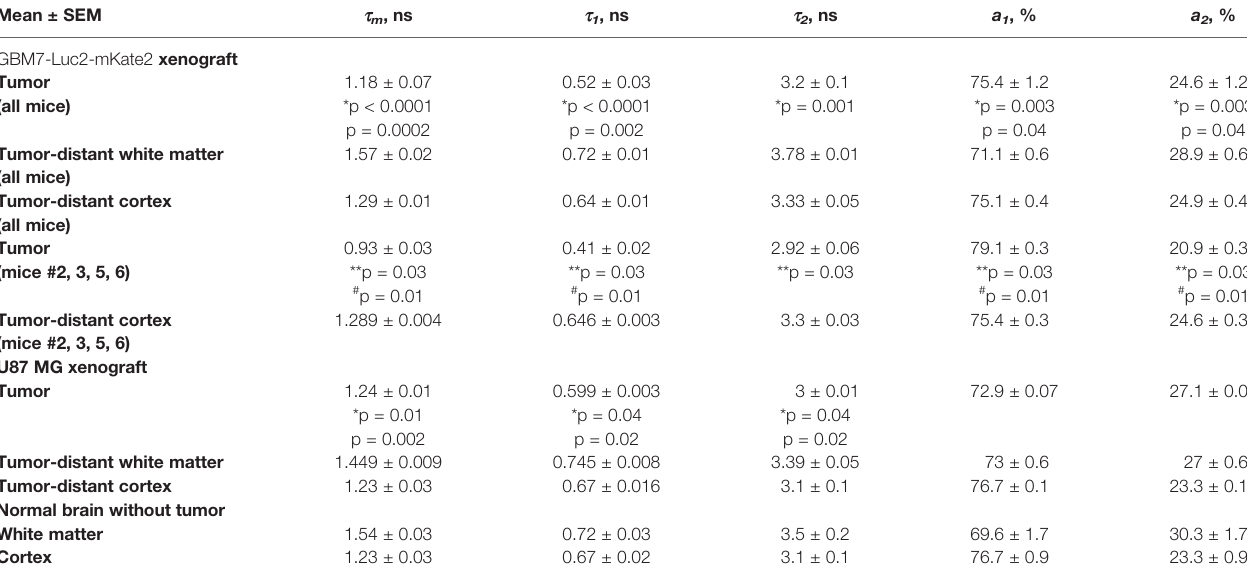
TABLE 2 | Auto fl uorescence lifetimes in GBM, white matter, and